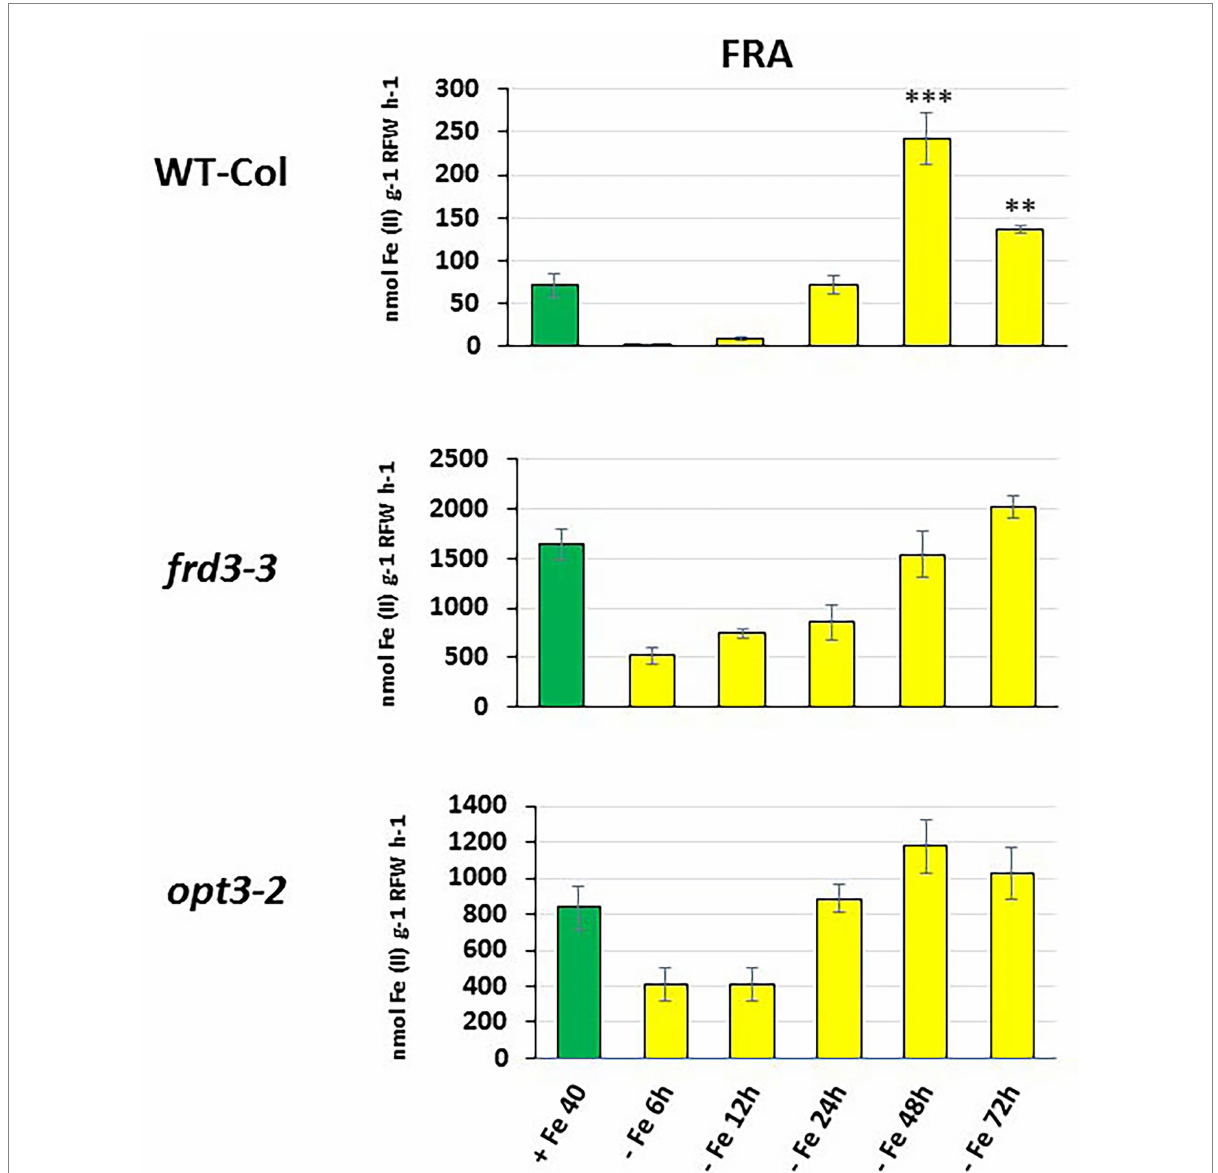
FIGURE 3 Time course of ferric reductase activity (FRA) in roots of Arabidopsis WT Columbia and its LODIS defective mutants frd3-3 and opt3-2 grown under Fe-deficient conditions. Treatments as in Figure 1. After treatments, FRA was determined along time. Data represent the mean of 6 replicates ± S.E. Bars with ** or *** indicate significant differences ( p < 0.01 or p < 0.001, respectively) in relation to the +Fe40 treatment according to the Dunnett’s